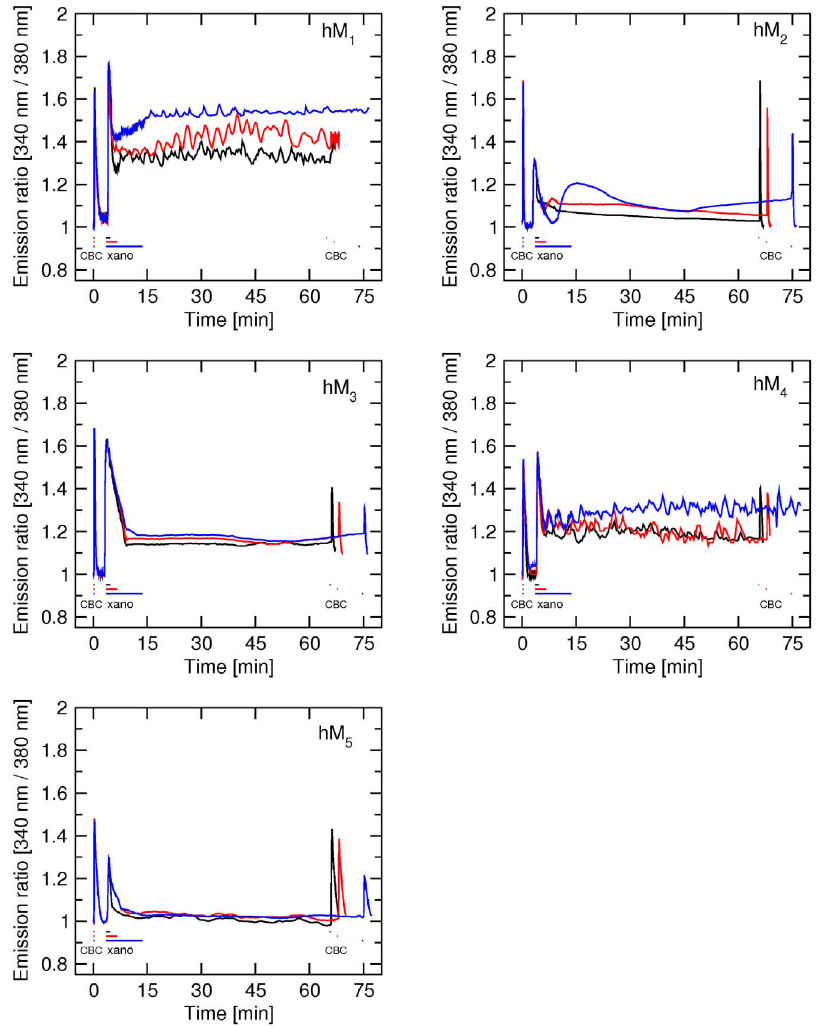
Figure 2. Effects of short-term application of xanomeline on the time-course of changes in intracellular calcium concentration in CHO cells expressing individual subtypes of muscarinic receptors. The time-course of intracellular calcium concentration (abscissa)